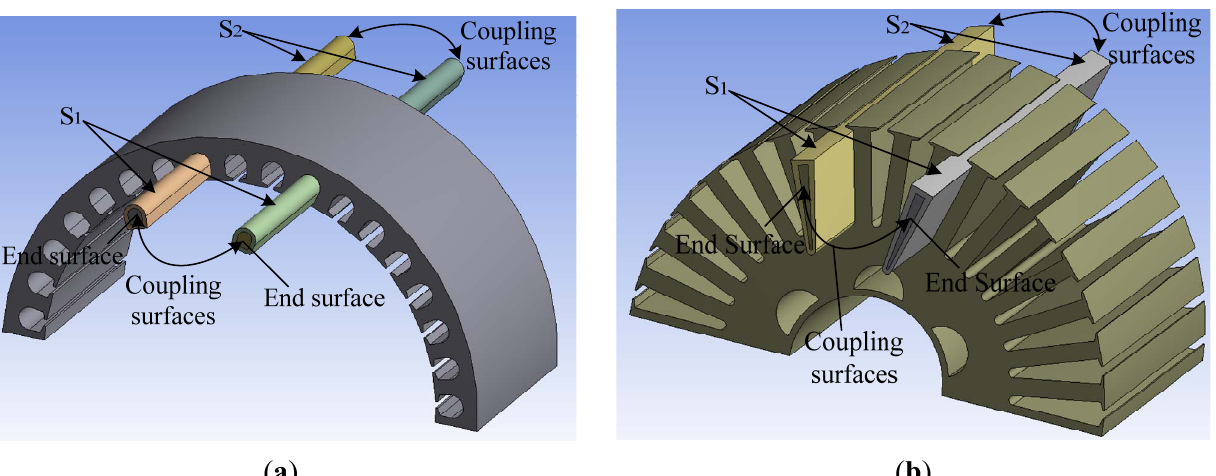
Figure 10. ( a ) Stator end winding simplified model; and ( b ) inner end winding simplified